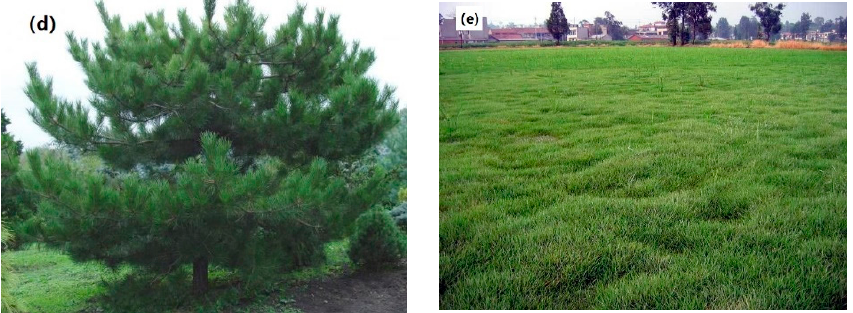
Figure 2. Map with vegetation types ( a ) and forest land photos (( b ) Platycladus orientalis ; ( c ) Quercus variabilis ; ( d ) Pinus tabulaeformis ; ( e ) grass ( Lolium perenne )).